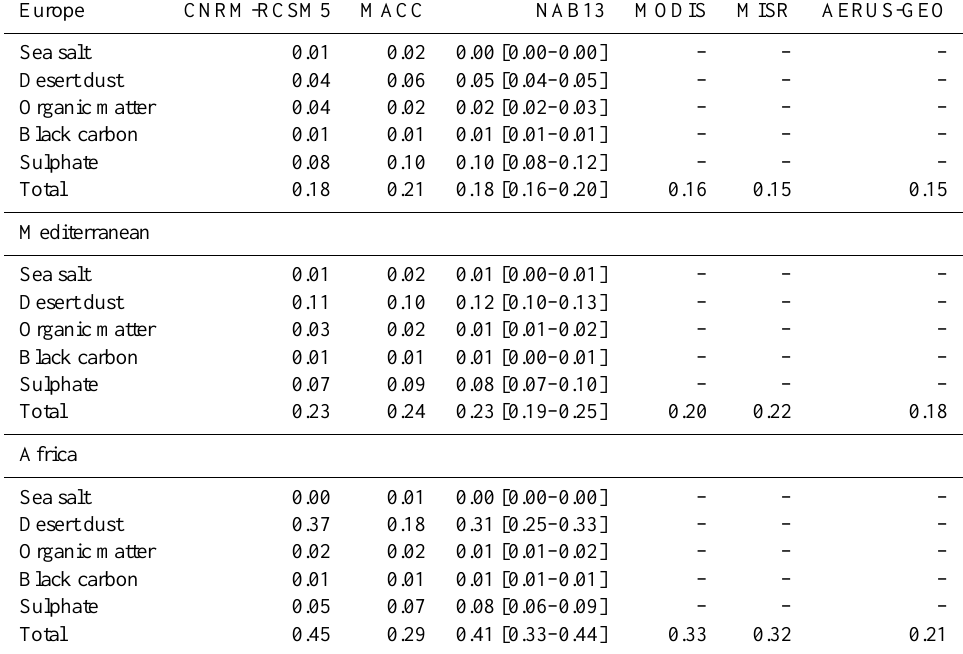
Table 3. Total AOD and components for the five aerosol types simulated by CNRM-RCSM5 and the MACC reanalysis in summer 2012 over Europe (continental area up to 30 ◦ E), the Mediterranean Sea and northern Africa (continental area up to 25 ◦ N). Averages in summer from NAB13, the climatology of Nabat et al. (2013), have also been indicated with the minimum and maximum summer values